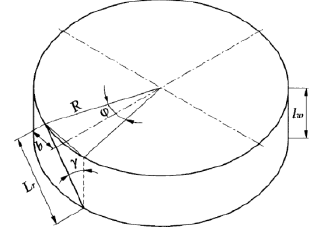
Fig. 2. The wheel design parameter calculation